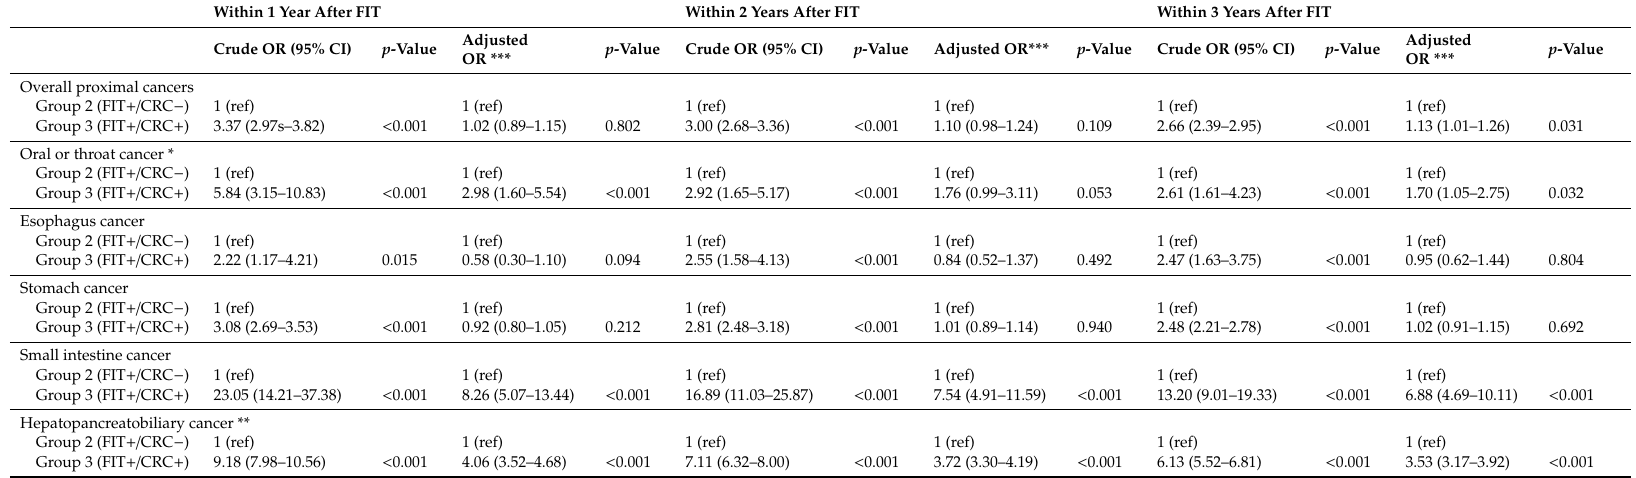
Table 4. Comparisons of the risks of proximal cancers between FIT +/ CRC − patients and FIT +/ CRC + patients. Within 1 Year After